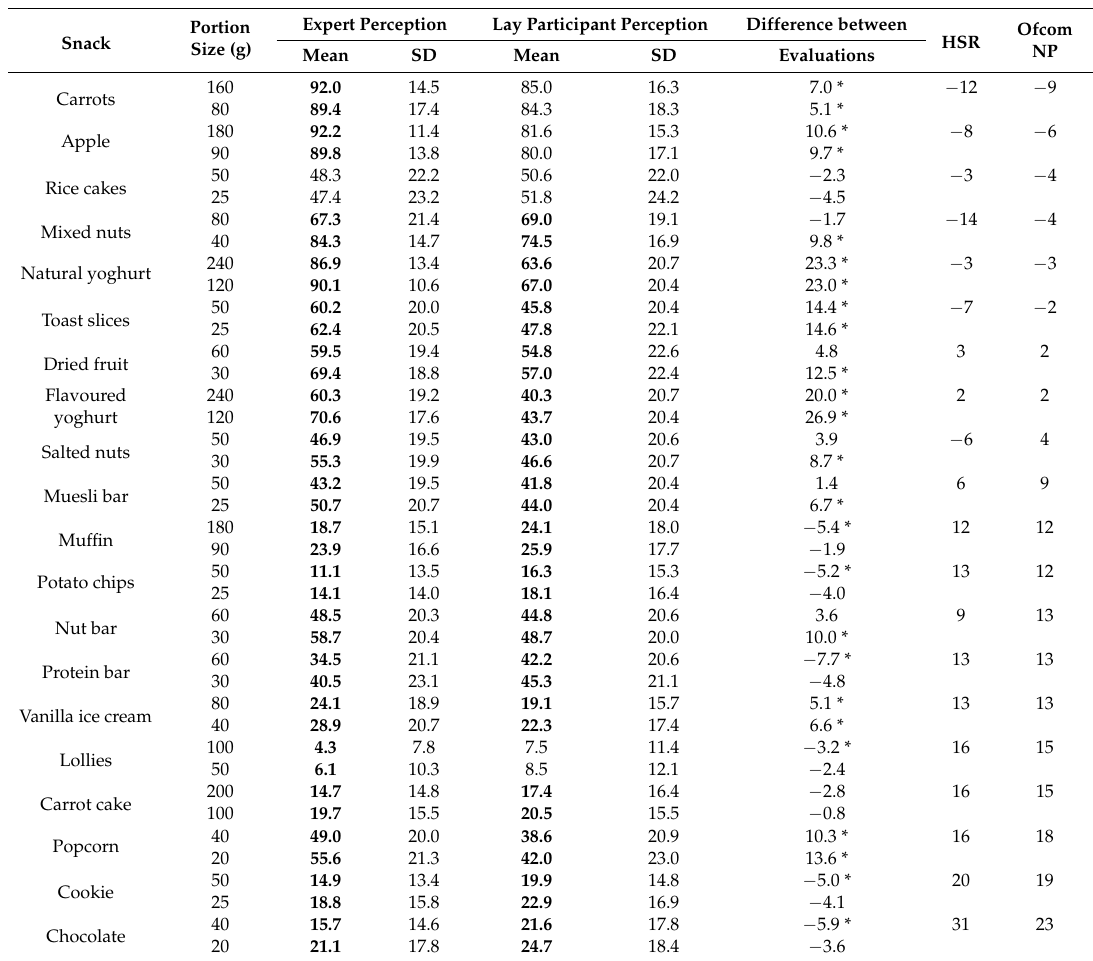
Table 3. Experts ( N = 206) and lay participants ( N = 269) mean nutritiousness evaluations on a scale from 0 (not nutritious) to 100 (very nutritious), Ofcom nutrient profile (NP) scores and Health Star Rating (HSR) scores of N = 20